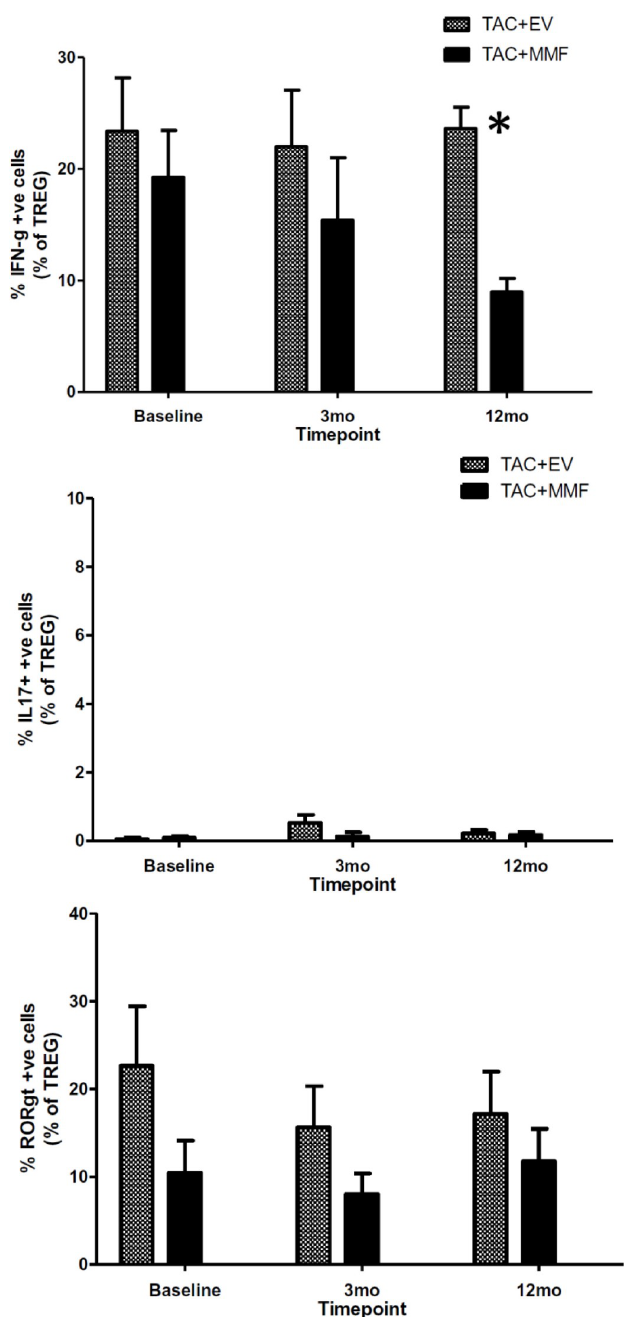
Fig 5. Intracellular cytokine and transcription factor staining for interferon- γ , interlekin-17 (IL-17) and RAR- related orphan receptor gamma 2 (ROR γ t) in CD4 + CD25 hi FOXP3 + regulatory T cells between study groups. The number of subjects analyzed at—Baseline: TAC+EVR N = 15,TAC+MMF N = 13; 3 mo: TAC+EVR N = 14,TAC +MMF N = 9; 12 mo: TAC+EVR N = 15,TAC+MMF N = 12. Please Tables D, E and F in S5 File for complete